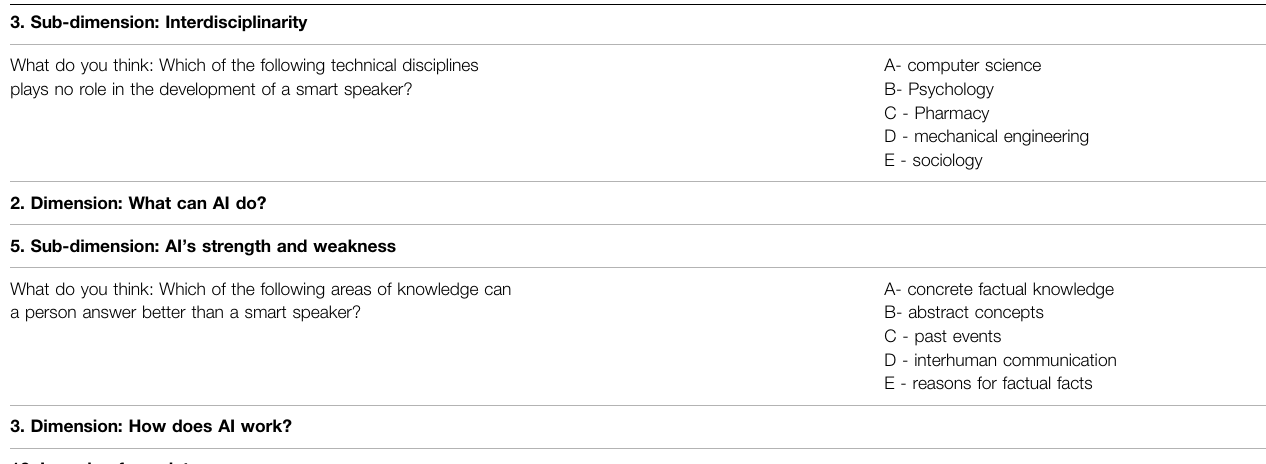
TABLE 1 | Item Pool: Example items of the 16 dimensions of (voice-based) conversational agent literacy on the example of a smart speaker. 1. Dimension what is